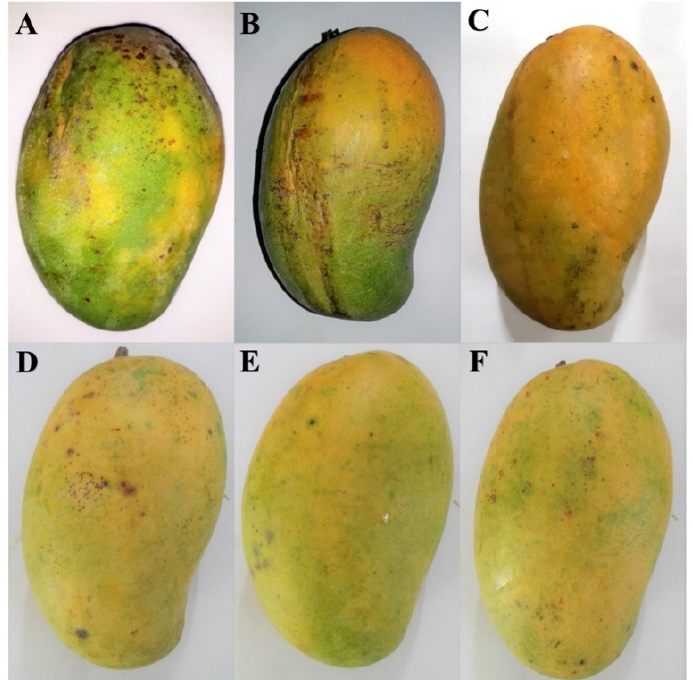
Figure 2: Shriveling of mango cv. ‘Karthakolomban’ subjected to dip treatment stored at 12 - 14 ℃ for 10 d and after induced ripening. A. Control I (distilled water) B. Control II (distilled water + gelatin) C. 0.1% carbendazim D. Aloe vera gel E. Aloe vera gel + 2.0 µL/mL cinnamon leaf oil F. Aloe vera gel + 2.0 µL/mL cinnamon bark